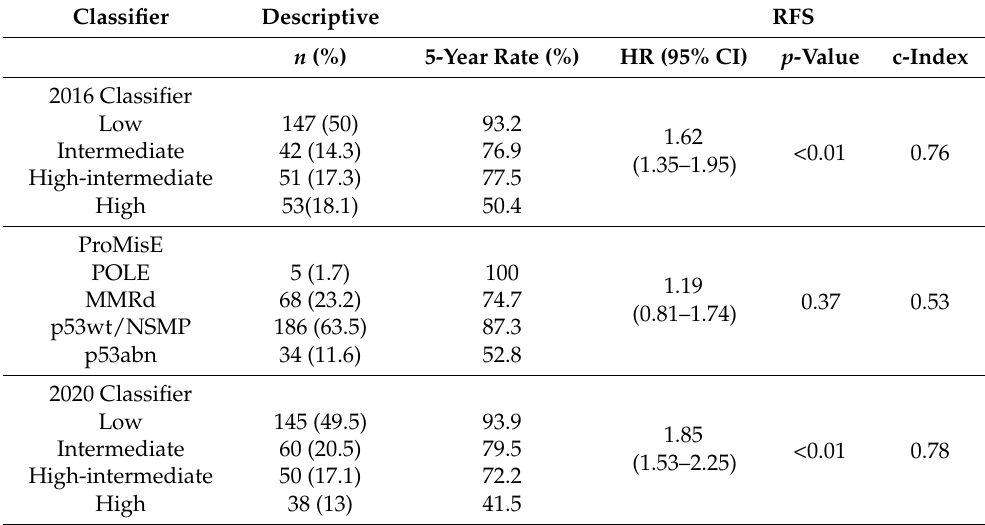
Table 2. Risk stratification tools accuracy comparison by relapse-free